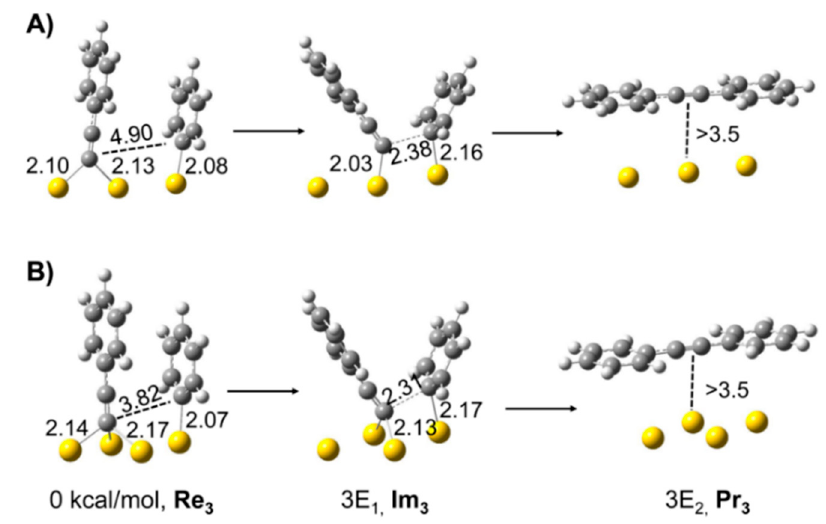
Figure 1. Proposed pathway for the cross-coupling on the ( A ) Au(100) and ( B ) Au(111). Reproduced with permission from [26]. Elsevier, 2015.